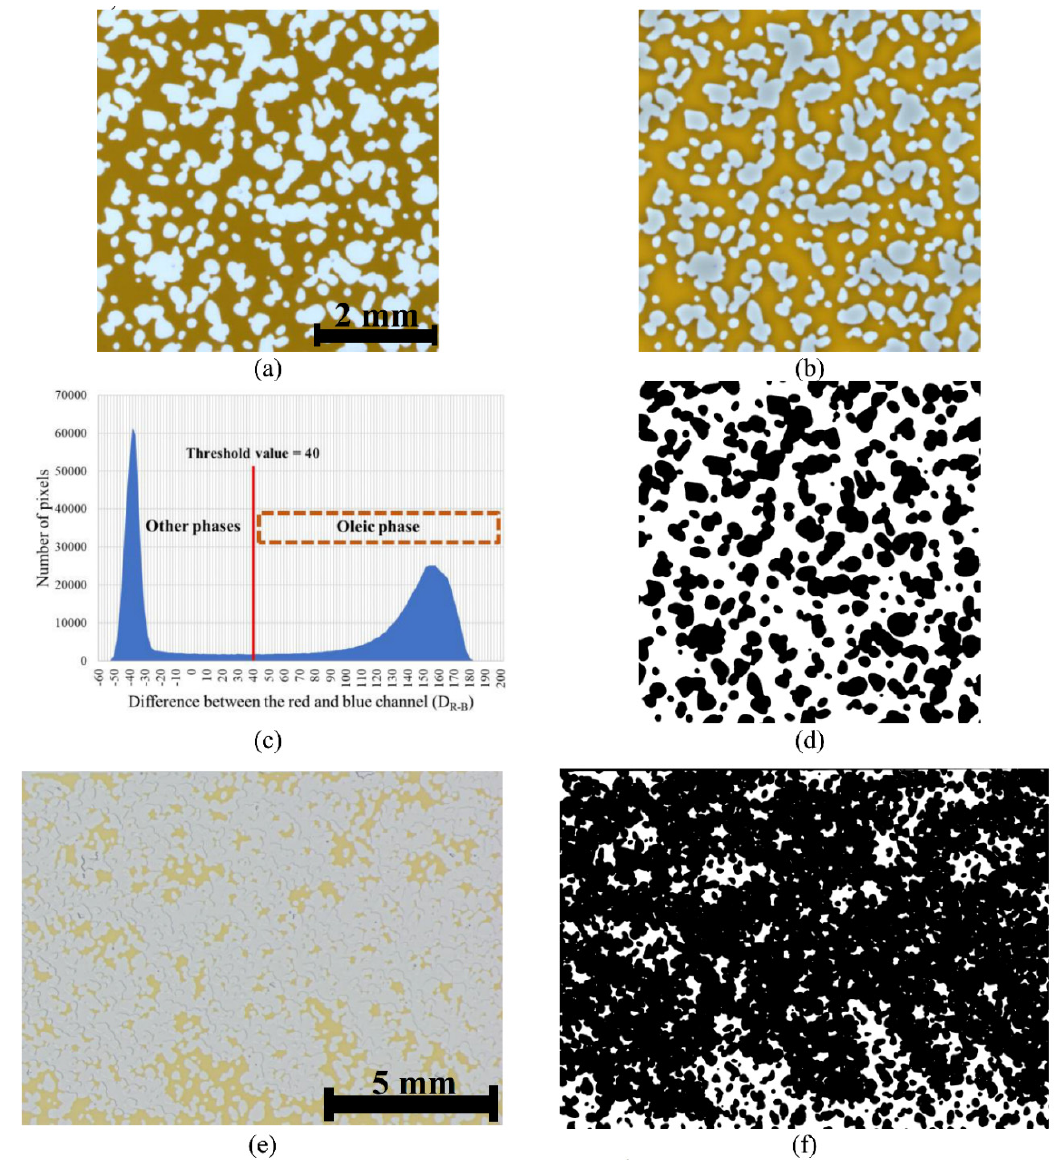
Figure 3. ( a ) a square section (5.62 × 5.62 mm 2 ) of the microfluidic chip saturated with oil (oil: